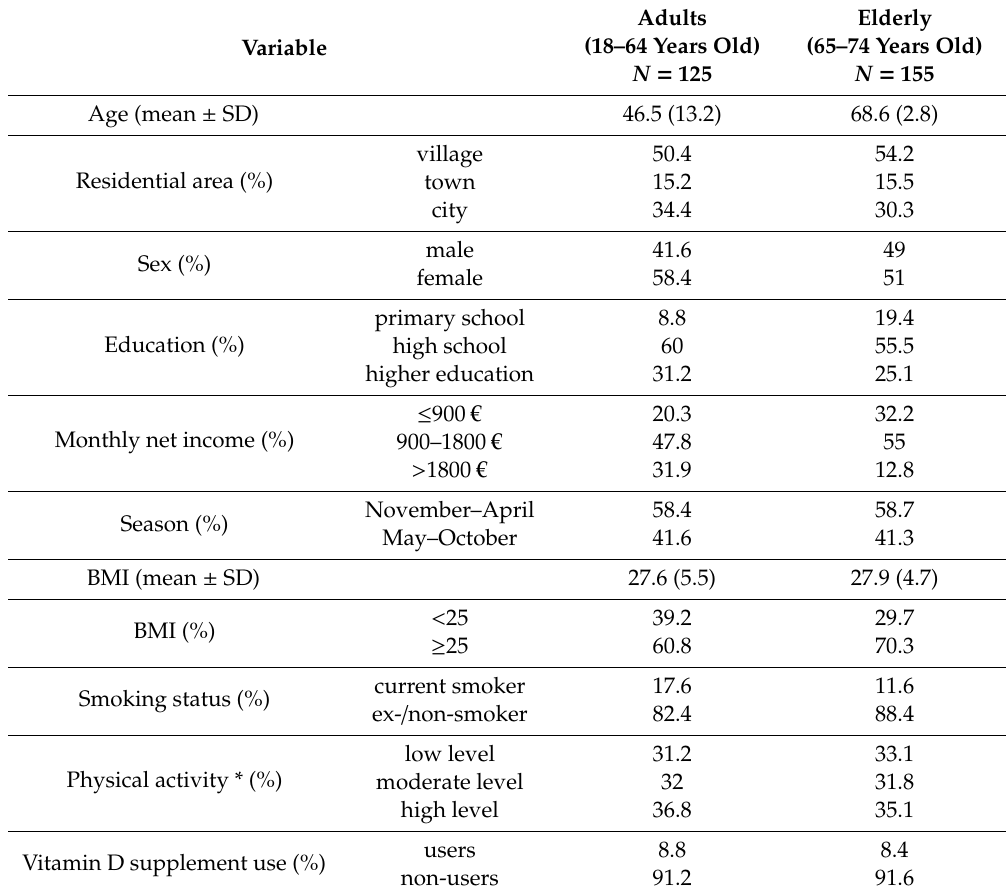
Table 1. Descriptive characteristics of the